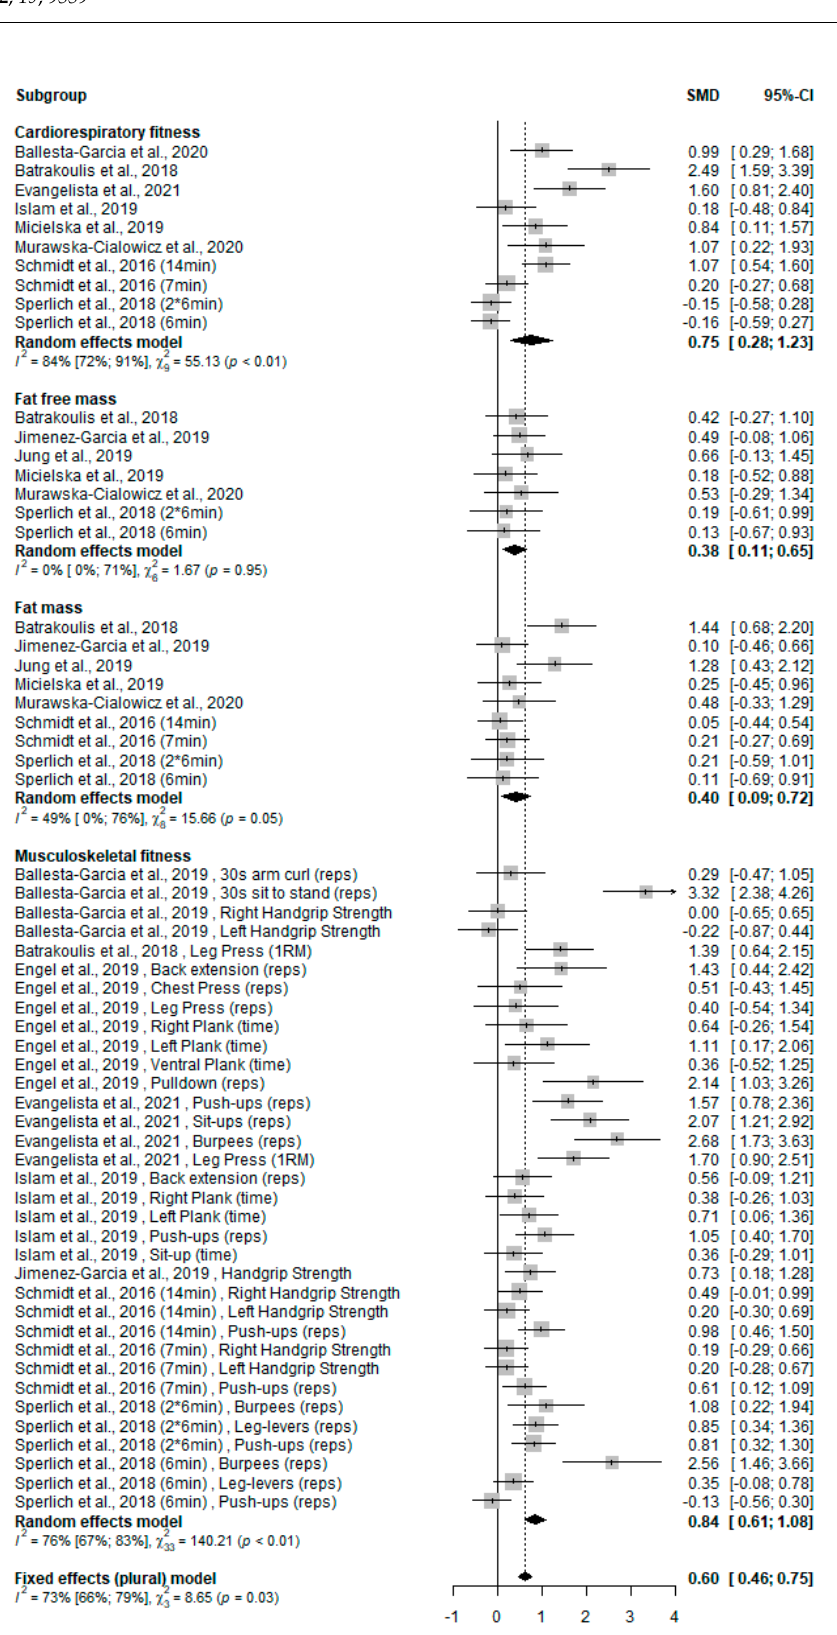
Figure 2. Forest plot of standardized mean difference (SMD) and confidence interval (CI) for the comparison WB-HIIT vs. no exercise. Positive values favor WB-HIIT. Subgroups mean effect and overall effect are written in bold. Reps, number of repetitions performed during a certain amount of time or until exhaustion; 1RM, one-repetition maximum.